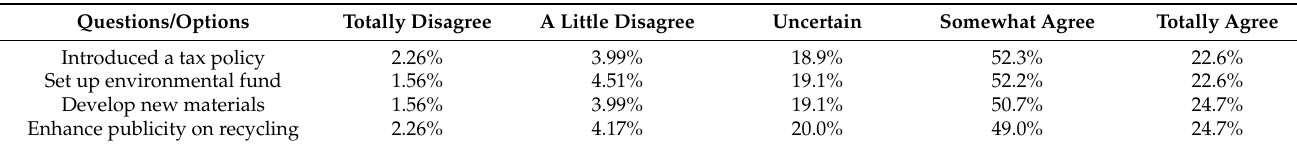
Table 5. Respondents’ awareness of government responsibility.